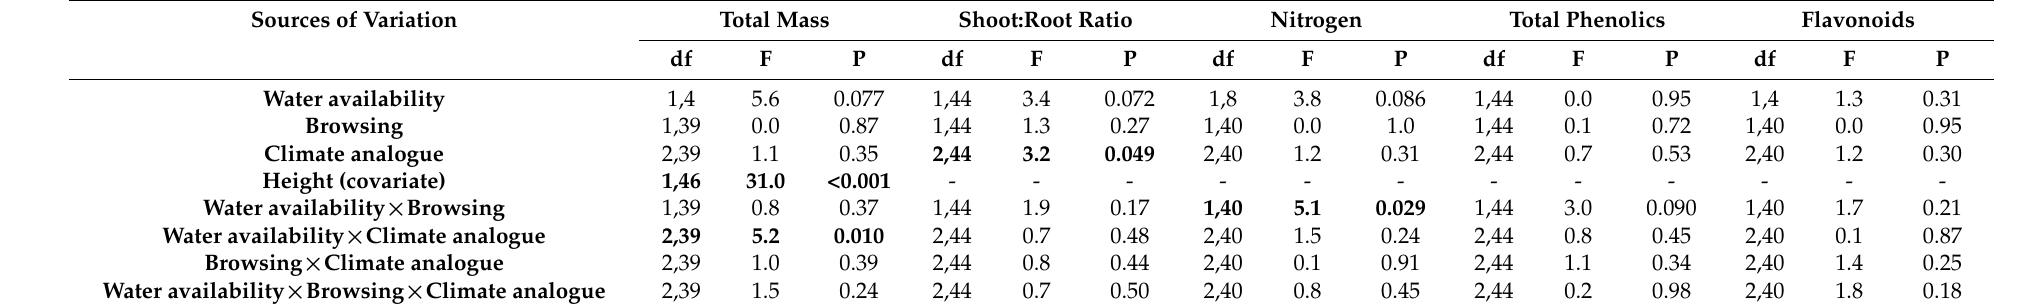
Table A3. ANOVA summary table for evaluating the effects of simulated winter browsing, water availability, seedling climate analogue (2018, 2050, 2080 analogues) and their interaction on northern red oak ( Quercus rubra L.) total mass, shoot:root ratio and chemical composition (nitrogen, total phenolics and flavonoids concentration). Seedlings were grown under different levels of water availability during a ten week greenhouse